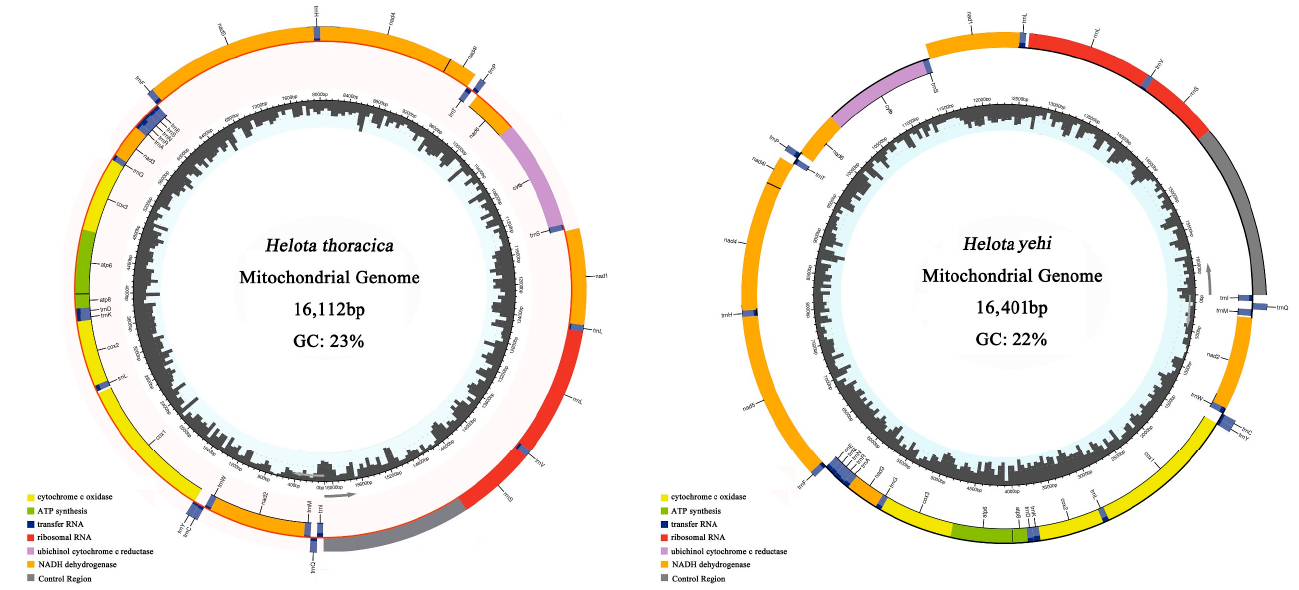
Figure 1. Mitochondrial map of H. thoracica and H. yehi . The cytochrome c oxidase (COX), ATP synthesis (ATP), transfer RNA (tRNAs), ribosomal RNA (rRNAs), ubichinol cytochrome c reductase (CYTB), NADH dehydrogenase (NADH) and control region (CR) are denoted by the different color blocks. The inside circles show the G + C contents of mitochondrial genome. Genes outside the map are transcribed counterclockwise, whereas those inside are transcribed clockwise.